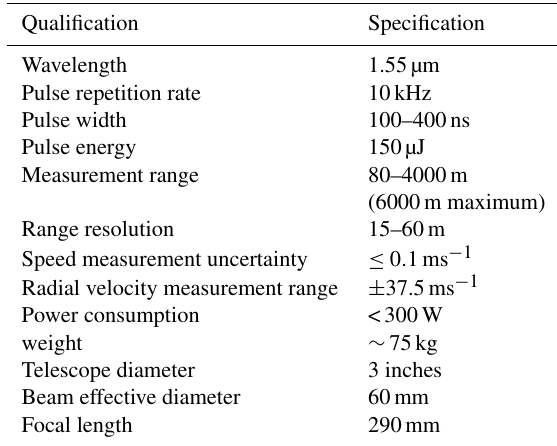
Table 1. Component Parameters of the CDL